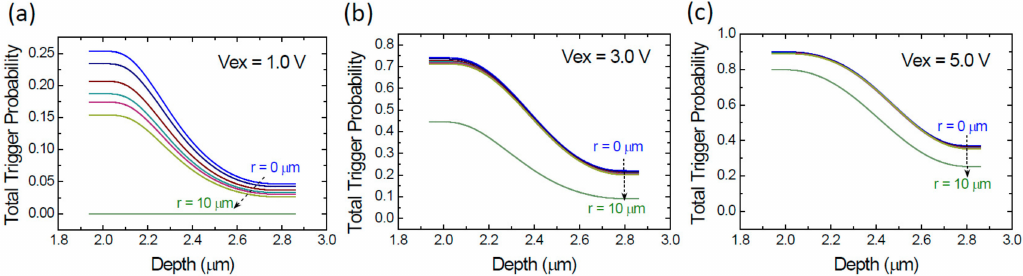
Figure 4. Simulated total trigger probability ( P t ) as a function of the depth at various r -positions including r = 0, 4, 6, 7, 8, 9, and 10 µ m and at the three excess voltages Vex. ( a ) Vex = 1.0 V; ( b ) Vex = 3.0 V; ( c ) Vex = 5.0